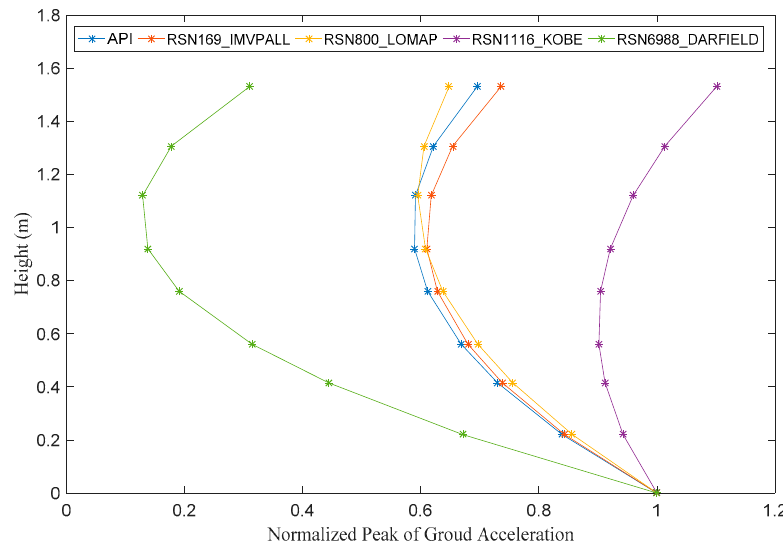
Figure 21. The variation trend of peak acceleration in the height direction of the platform by bidirectional seismic excitation in water.